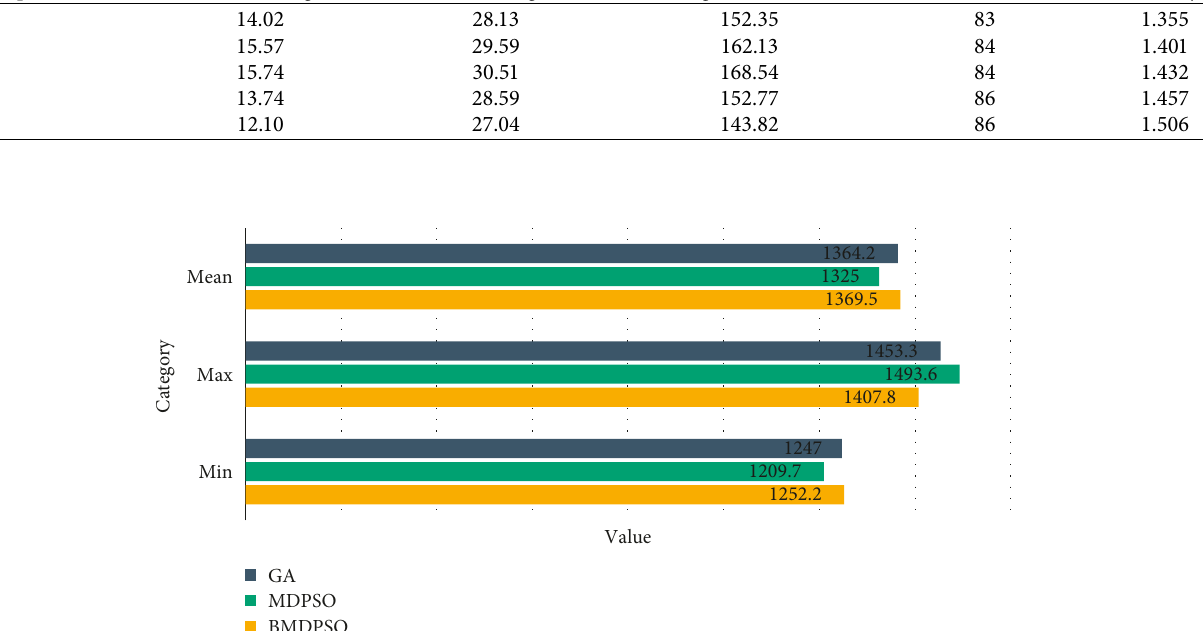
Table 6: Influence of different content of mica powder on the mechanical properties of composite materials. Mica powder